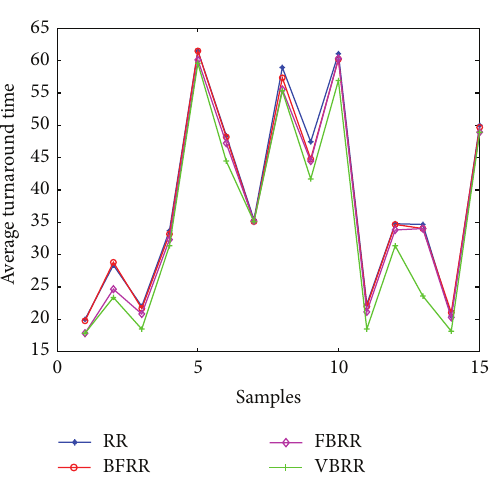
Figure 13: Average turnaround time.